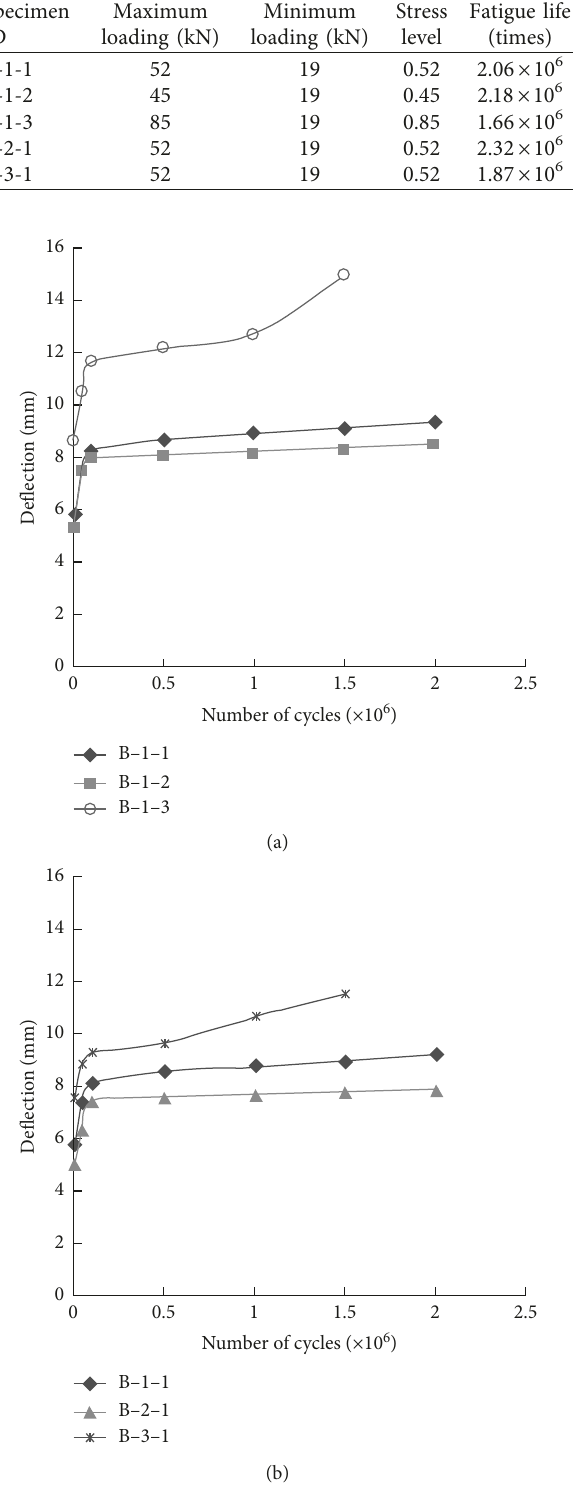
Figure 3: Deflection-cycle number the stress level was, the larger the midspan deflection would be. By increasing the stress level, the slope would be steeper and the residual deflection would be more significant as well [15].